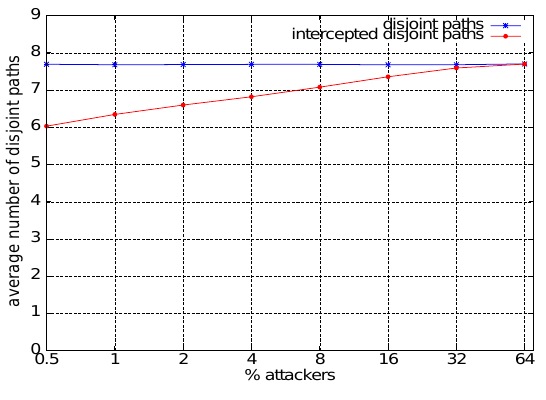
Figure 10. Average number of disjoint paths (total and intercepted) per source-destination pair in ER 20k-node networks.